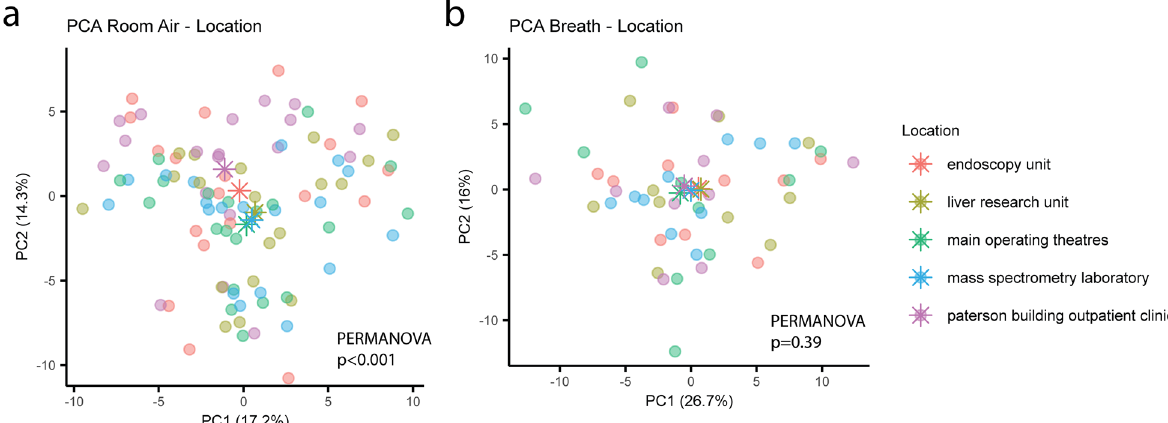
Figure 3. Variation of ambient room air, but not breath, VOC profiles differ across sampling locations, unsupervised analysis with PCA revealed separation between room air samples collected in different locations but did not show separation for their corresponding breath samples. Asterisks represent group